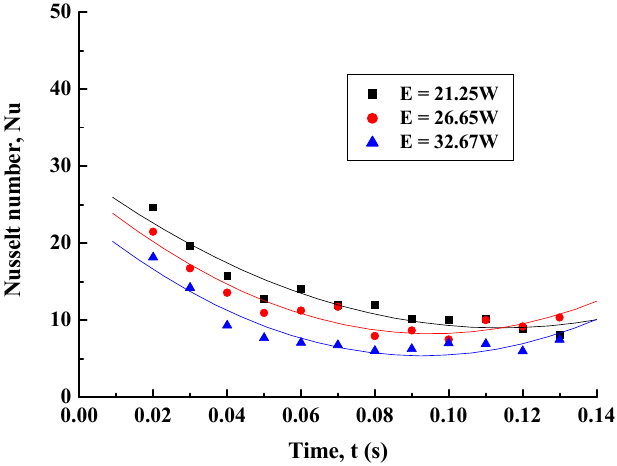
Figure 7. Variations in local Nusselt numbers for di ff erent heating energies with nickel sheet ( δ = 0.0125 mm).